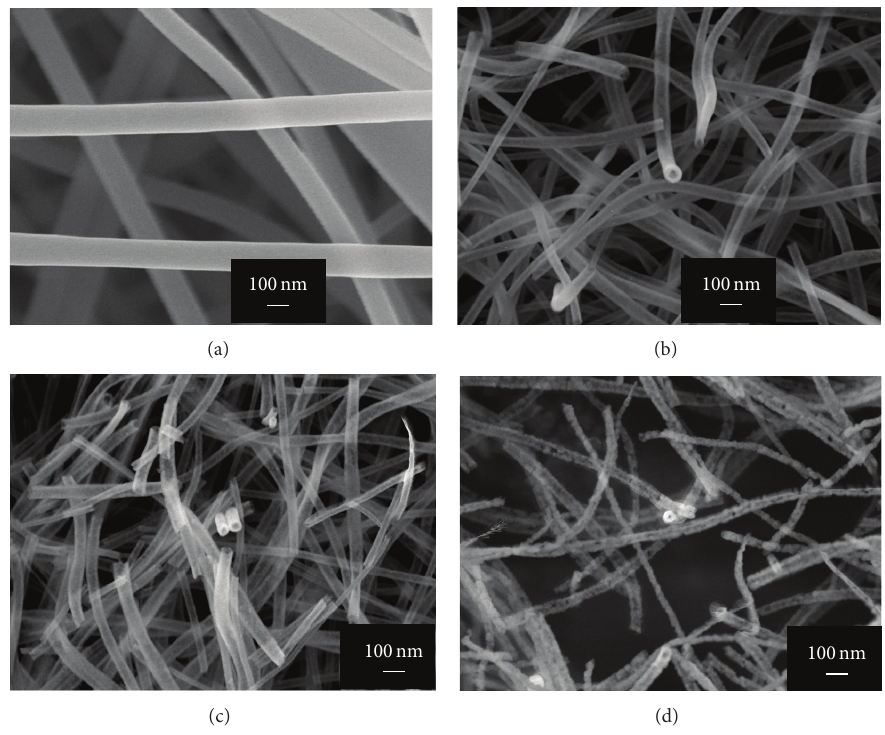
Figure 3: FESEM images of the GDC20 for (a) as-spun nanofibers and those calcined at (b) 500 ∘ C, (c) 700 ∘ C, and (d) 800 ∘ C for 8 h in air.